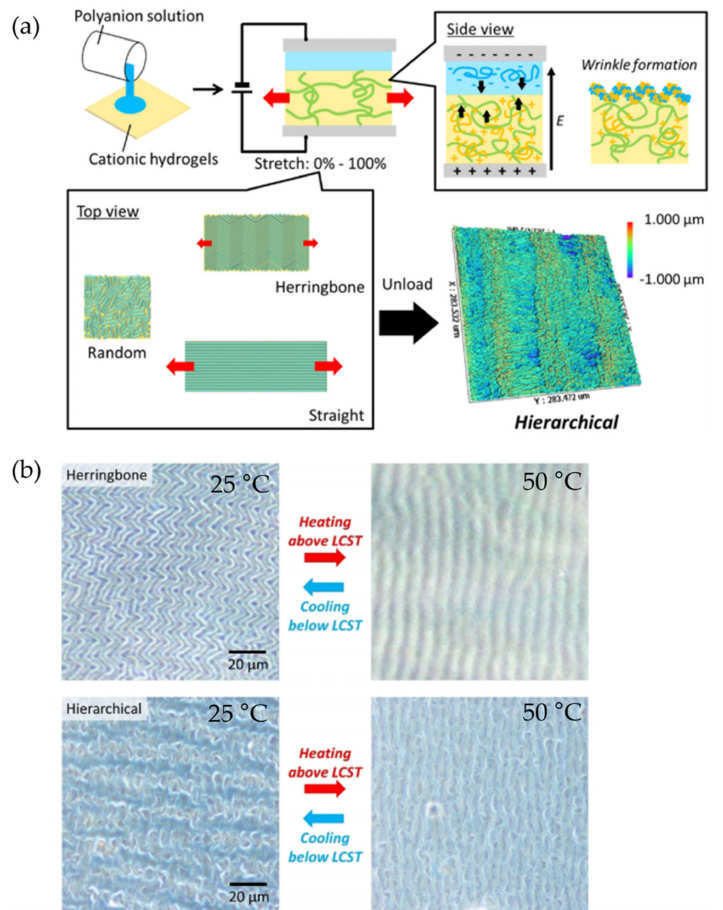
Figure 36. ( a ) Experimental procedure for wrinkle formation on the hydrogel surface by elec- trophoretic fabrication under stretching and ( b ) thermoresponsive transformation of herringbone and hierarchical wrinkles structures. Reproduced with permission from reference [149]. Copyright 2020, American Chemical Society (ACS).